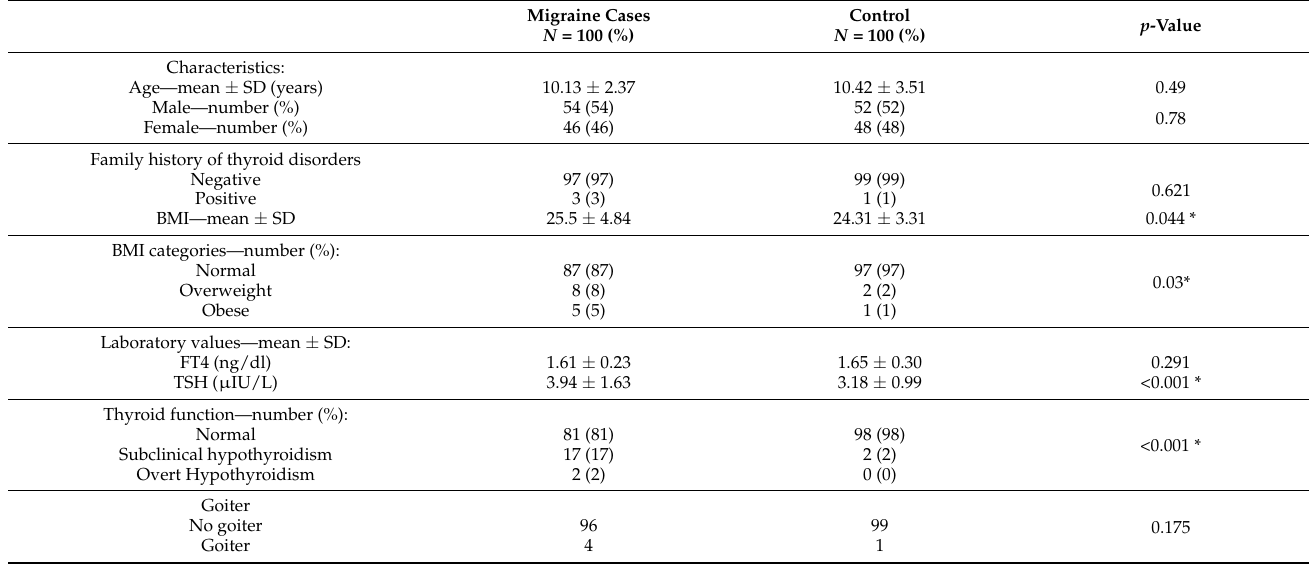
Table 1. Characteristics and clinical data comparison between cases and